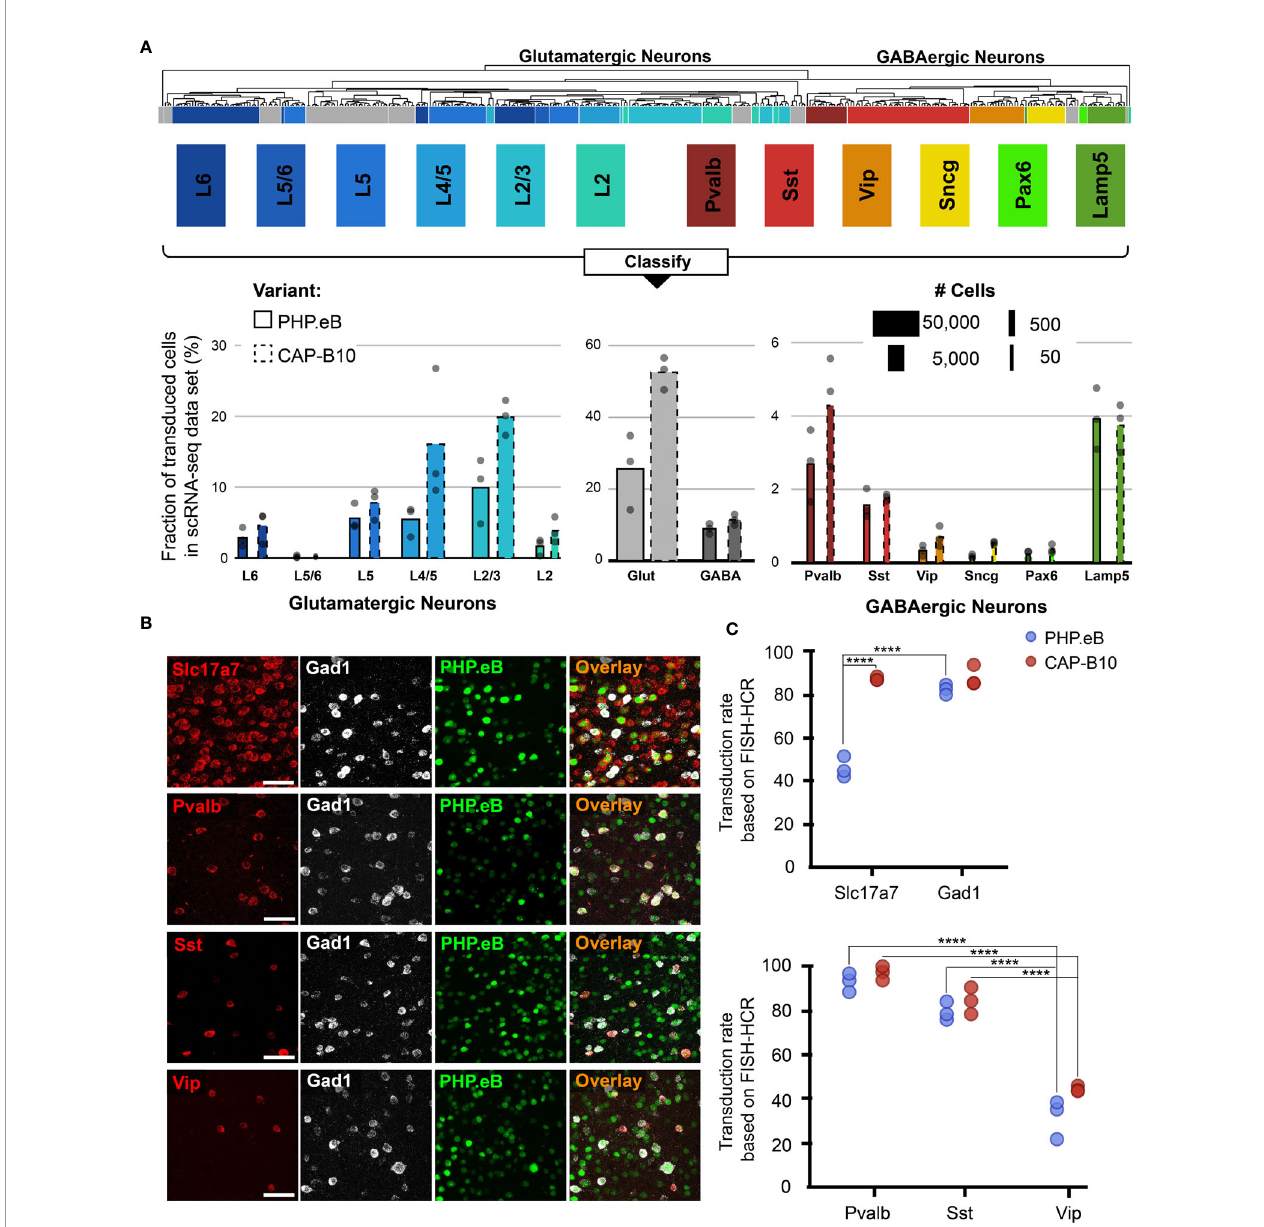
FIGURE 3 | In-depth AAV tropism characterization of neuronal subtypes at transcriptomic resolution. (A) Viral tropism pro fi ling across neuronal subtypes. Neuronal subtype annotations are predicted by a model learned from the Allen Institute reference dataset using scANVI (94, 95). Each dot represents data from one animal injected with AAV-PHP.eB and/or AAV.CAP-B10. Bar width indicates the total number of cells of a particular cell type present in our dataset. (B) Representative confocal images of cortical tissue from an animal injected with 1.5 ×10 11 vg of AAV-PHP.eB. Tissue was labeled with FISH-HCR for gene markers of glutamatergic neurons (Slc17a7) and GABAergic neurons (Gad1, Pvalb, Sst, Vip). AAV-PHP.eB shows the endogenous fl uorescence of mNeonGreen. Scale bar, 50 µm. (C) Con fi rmation of viral tropism biases across neuronal subtypes using FISH-HCR (3 mice per AAV variant, 1.5 ×10 11 vg dose). Dots represent the average values across three brain slices from one animal. Results from a two-way ANOVA with correction for multiple comparisons using Tukey ’ s test is reported with adjusted P- values (****P ≤ 0.0001; and P > 0.05 is not shown on the